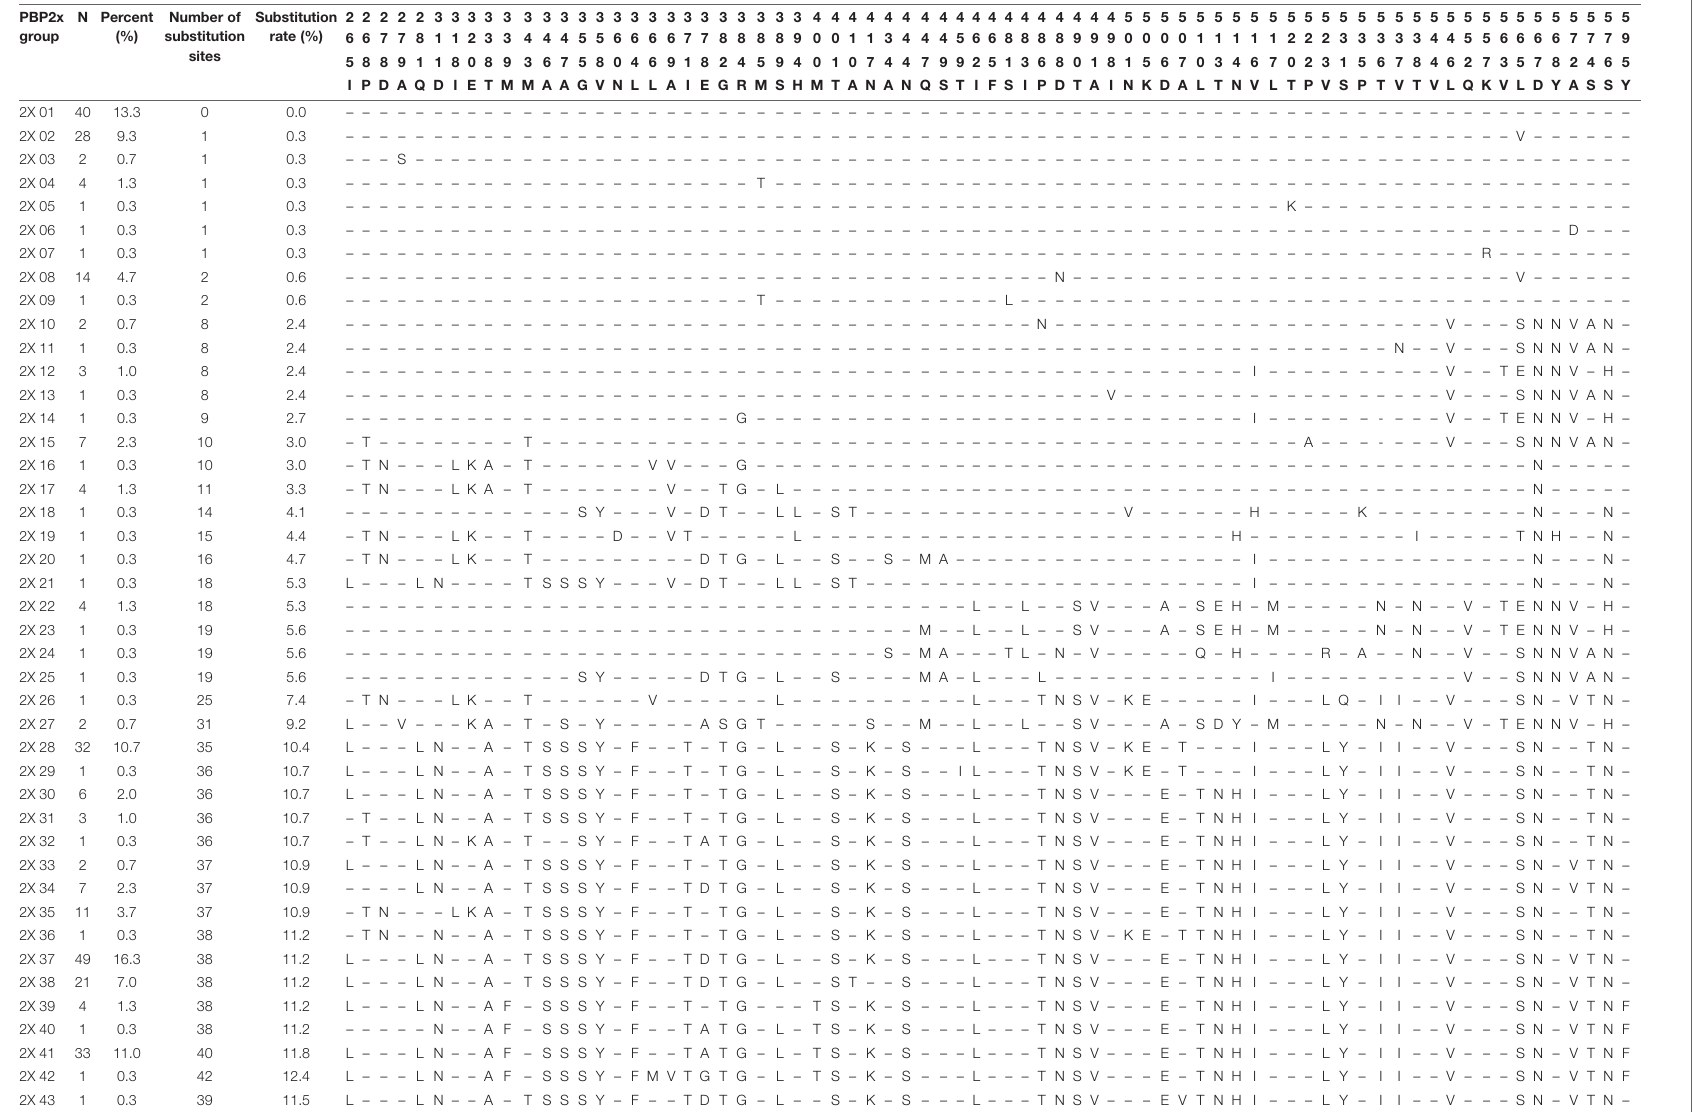
TABLE 7 | Deduced amino acid sequences of PBP2x in 300 S. pneumoniae isolates. PBP2x N Percent group